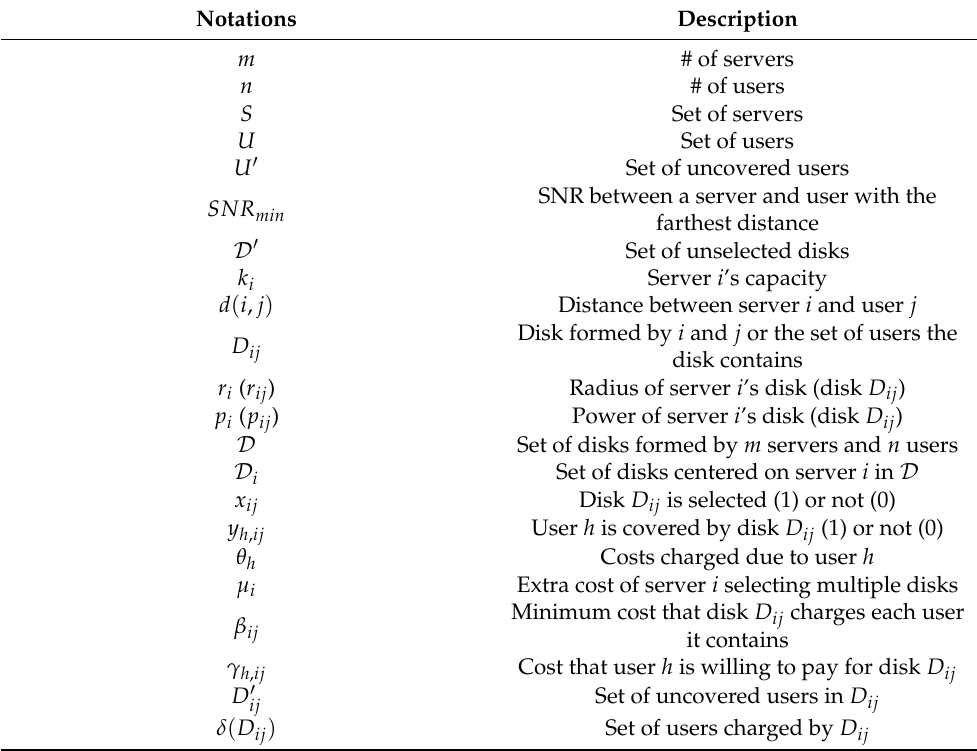
Table 1. Summary of